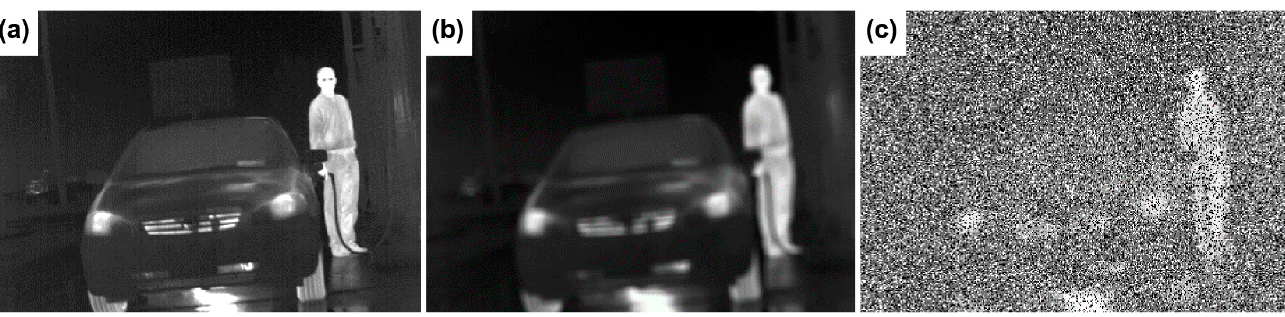
Figure 5. A comparison of deblurring effects of the two models on a station image. ( a ) The original station image, ( b ) the image deblurred using Lp_LOGS, and ( c ) the image deblurred using Lp_HOGS. ( d – f ) The Local enlarged images from the red boxes in ( a – c ), respectively. A comparison of Figure 4a,c with Figure 5b,c revealed satisfactory overall deblurring effects of Lp_LOGS and Lp_HOGS on images with the box blur. However, the image deblurred by Lp_LOGS contained more speckle noise than the image deblurred by Lp_HOGS. The images in the red boxes in Figure 5b,c are enlarged in Figure 5e,f, respec- tively. The upper halves of Figure 5e,f were mostly smooth areas. The model used to create Figure 5f removed salt-and-pepper noise more thoroughly than that used on Figure 5e and its visual effect was closer to the original image. The lower half mostly contained the edge area. Thus, the denoising effect was not evident. However, Figure 5f retained more detail from the original image. For example, the car logo is clearer. Overall, the visual effect of Figure 5f was closer to that of the original image, indicating that Lp_HOGS exhibited better deblurring performance than Lp_LOGS under the box blur. It was also reconfirmed that Lp_HOGS preserved more detail while suppressing the staircase effect of the deblurred im- ages.